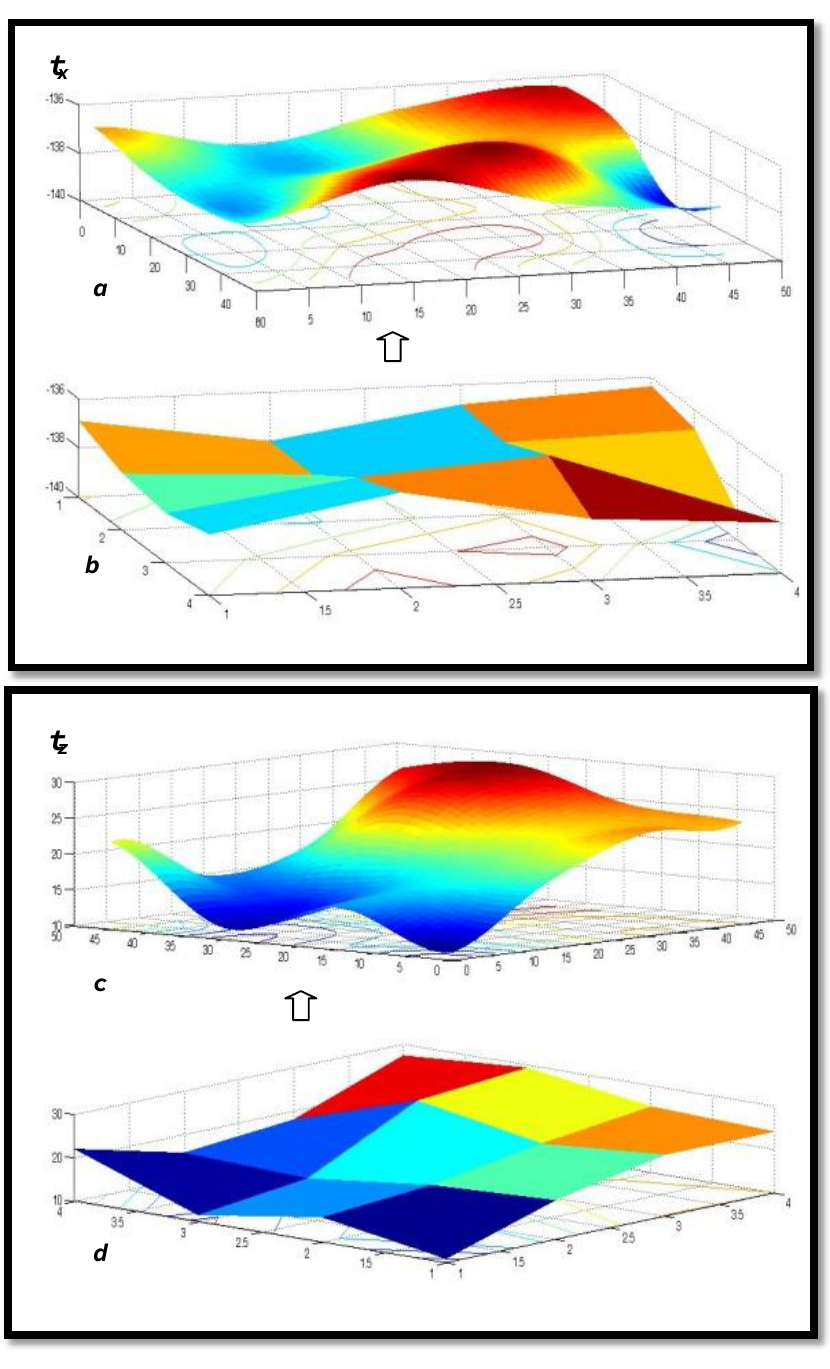
Figure 9. Bi-directional third degree parabolic interpolation for translation values t and t (right). ( b ) and ( d ) are displayed in the original 700 m DTPM resolution, while ( a ) z and ( c ) are displayed in the resulting 50 m resolution needed for morphing and